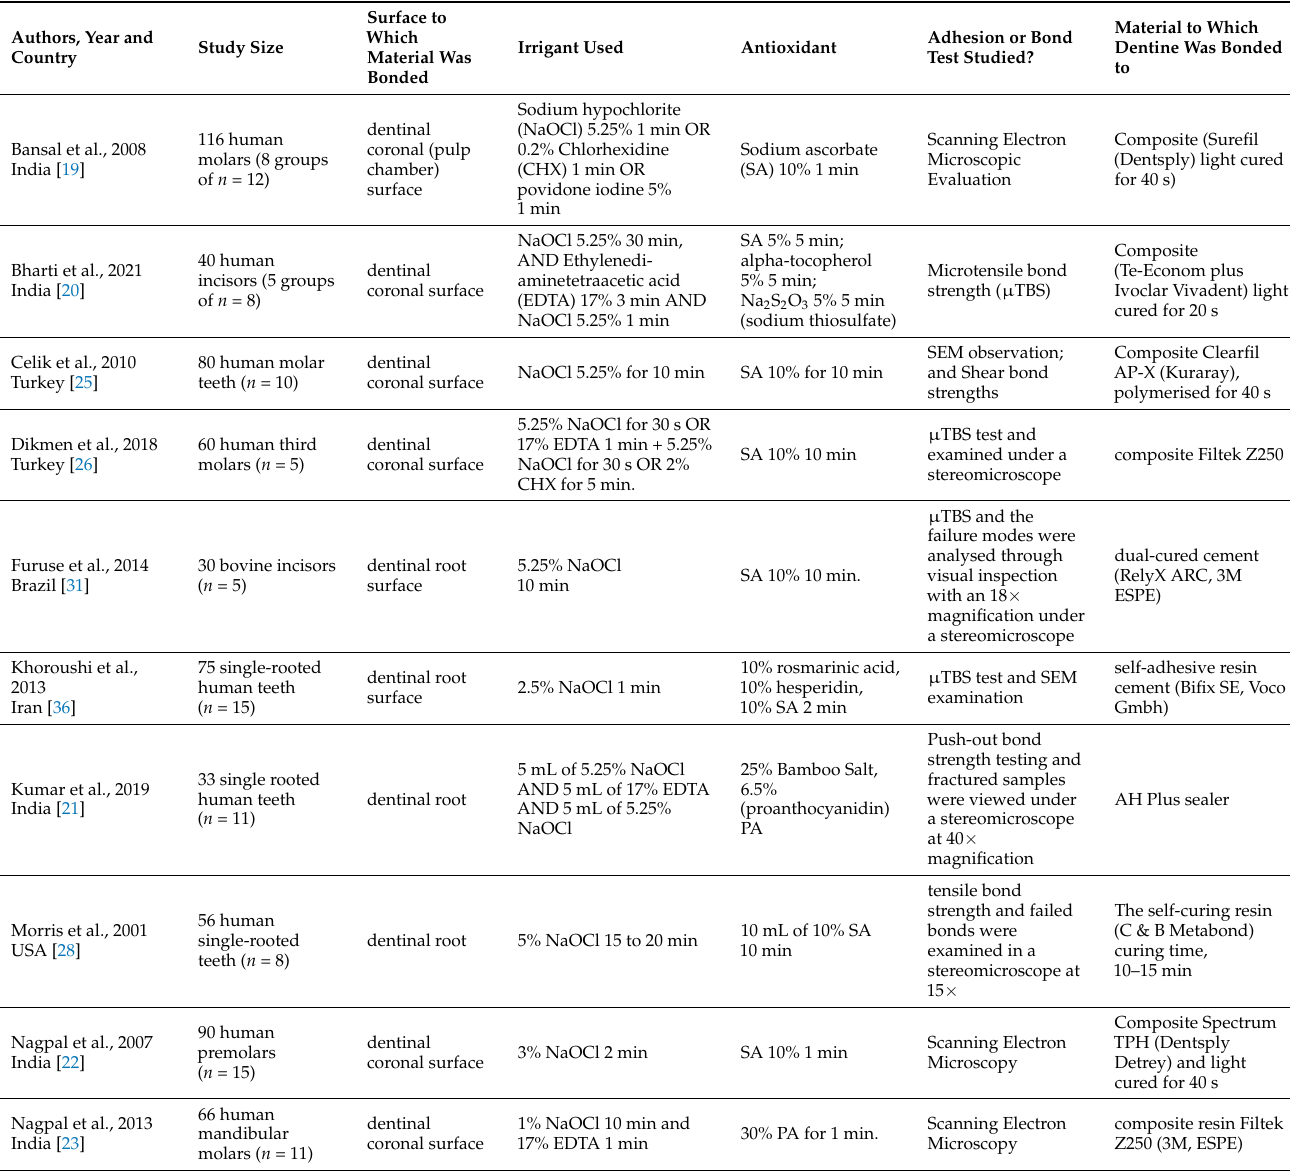
Table 2. Summary of the data extracted from the articles